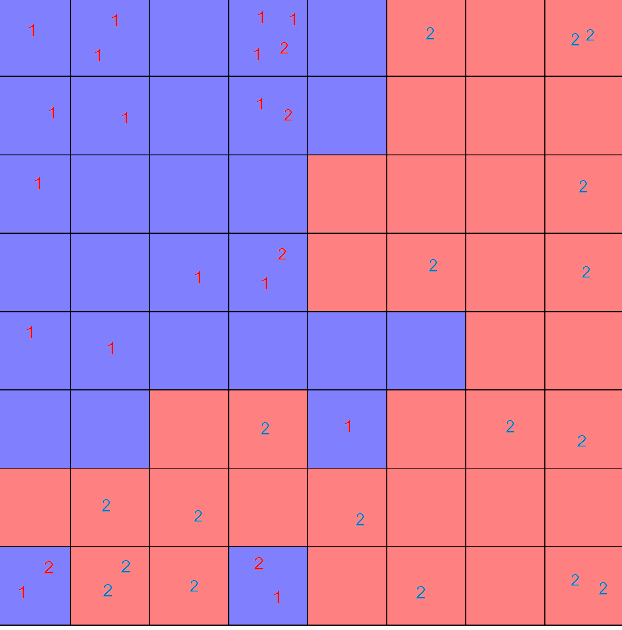
Figure 21. The assignation map of CPANN labeled with low (1) high (2) binding score. The neurons are colored in red or blue based on output layer of the network. The red area is assigned to high docking score compounds and the blue regions.